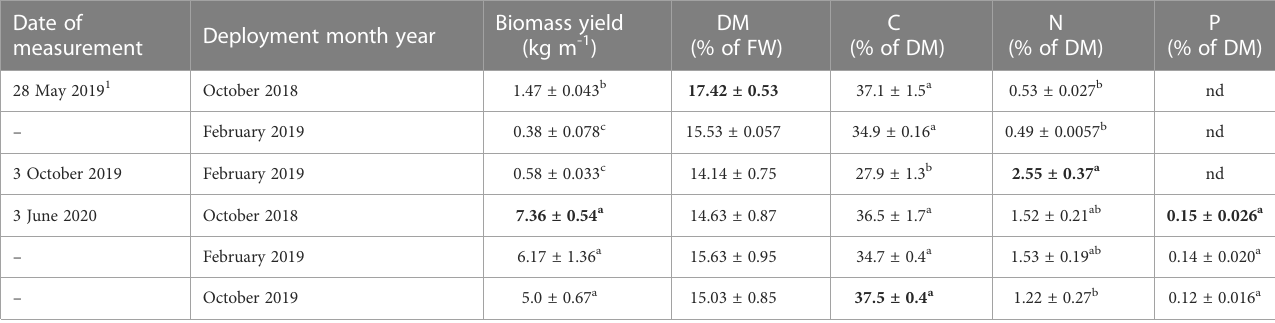
Data are shown as average ± SE, n = 3-5 for yield measurements and n = 3 for tissue measurements. nd, no data. Data marked in bold indicate the highest obtained values. 1 Data obtained from blades coppiced 15 cm above the meristem. Small letters 'a-c' indicate signi fi cant differences in biomass composition between measurements.